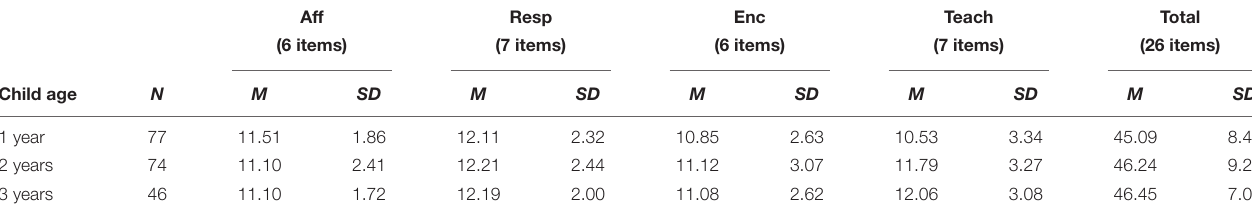
TABLE 2 | Spanish PICCOLO scores by child